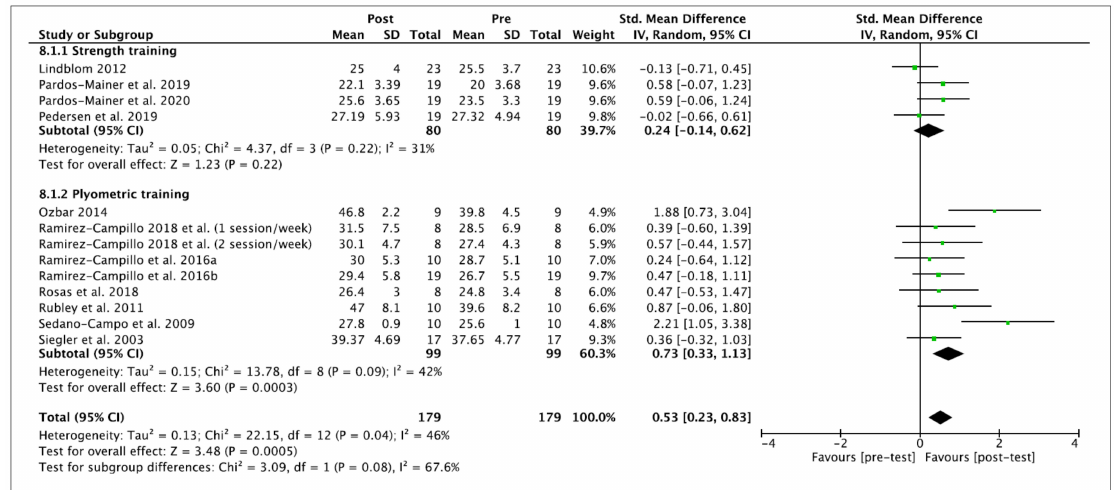
Figure 3. Forest plot of within-mode effect sizes with 95% confidence intervals (CIs) in vertical jump performance (cm). IV: inverse variance method; SD: standard deviation; Std: